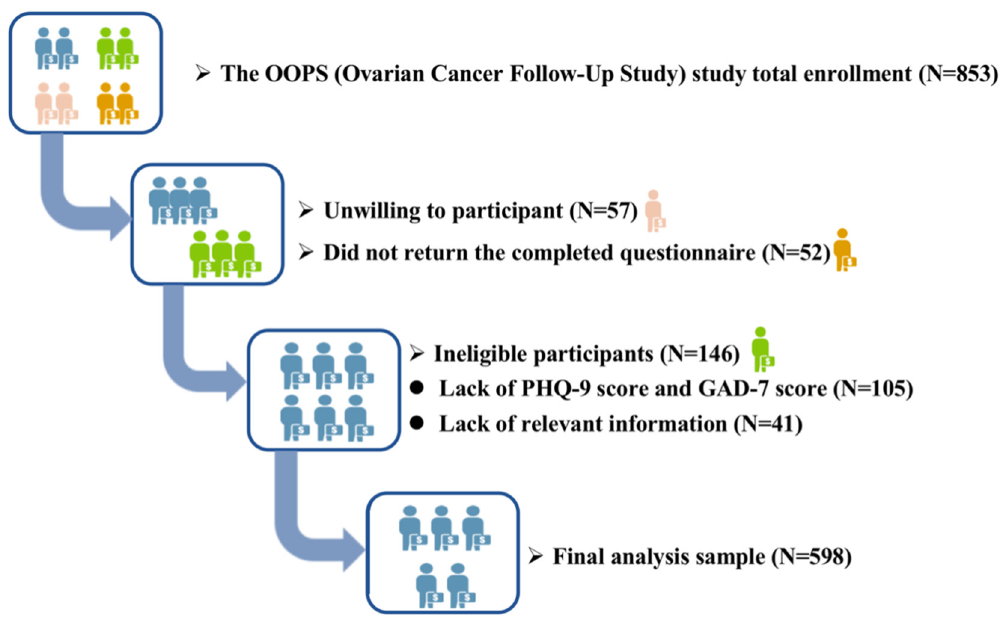
Figure 1. Flow of participants through the Ovarian Cancer Follow-Up Study (OOPS) study.